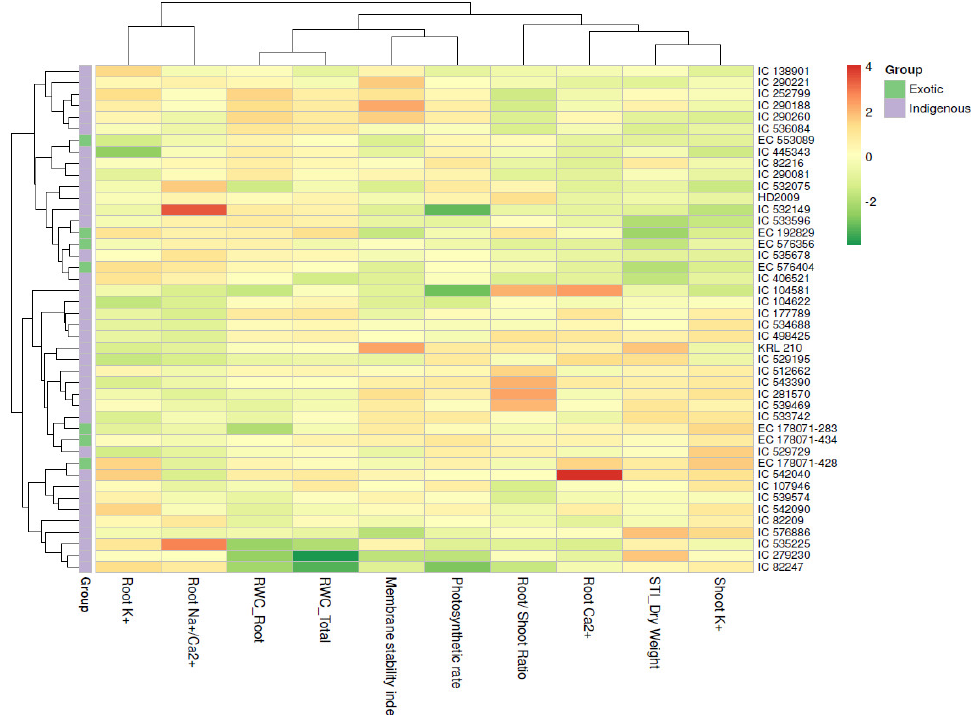
Figure 4. Clustering of wheat genotypes based on most contributing traits under salt stress condition (150 mM NaCl).